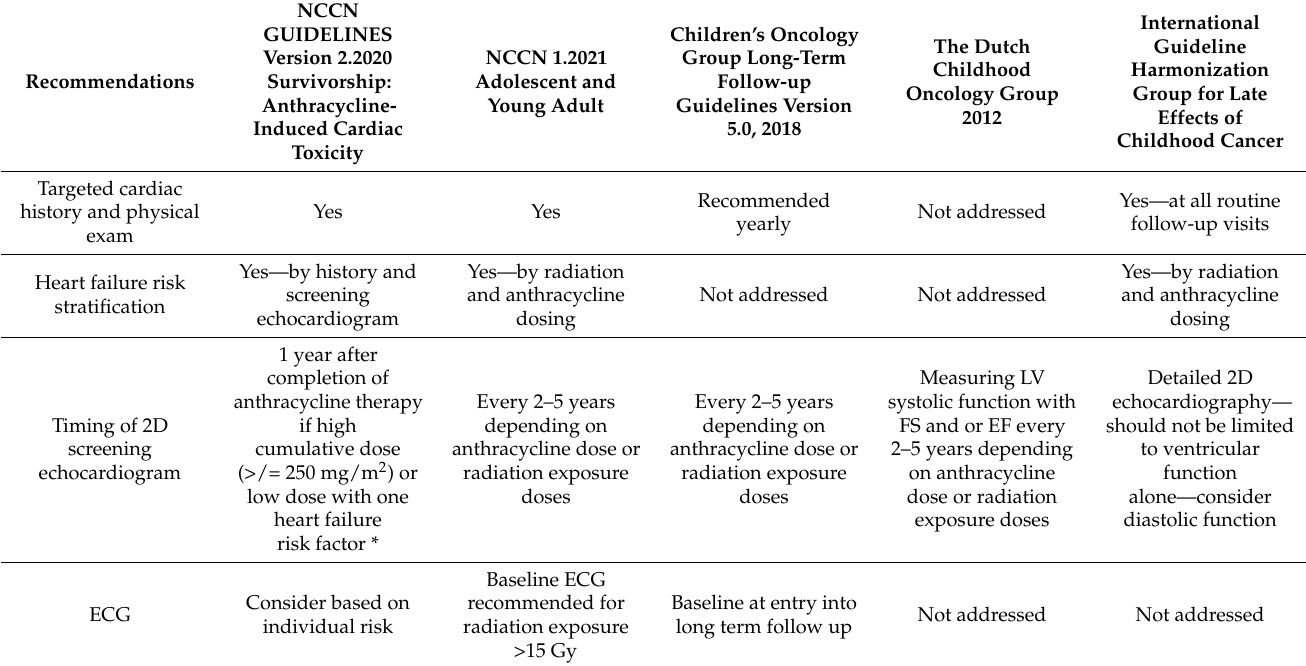
Table 1. Cardiotoxicity surveillance guidelines for survivors of pediatric